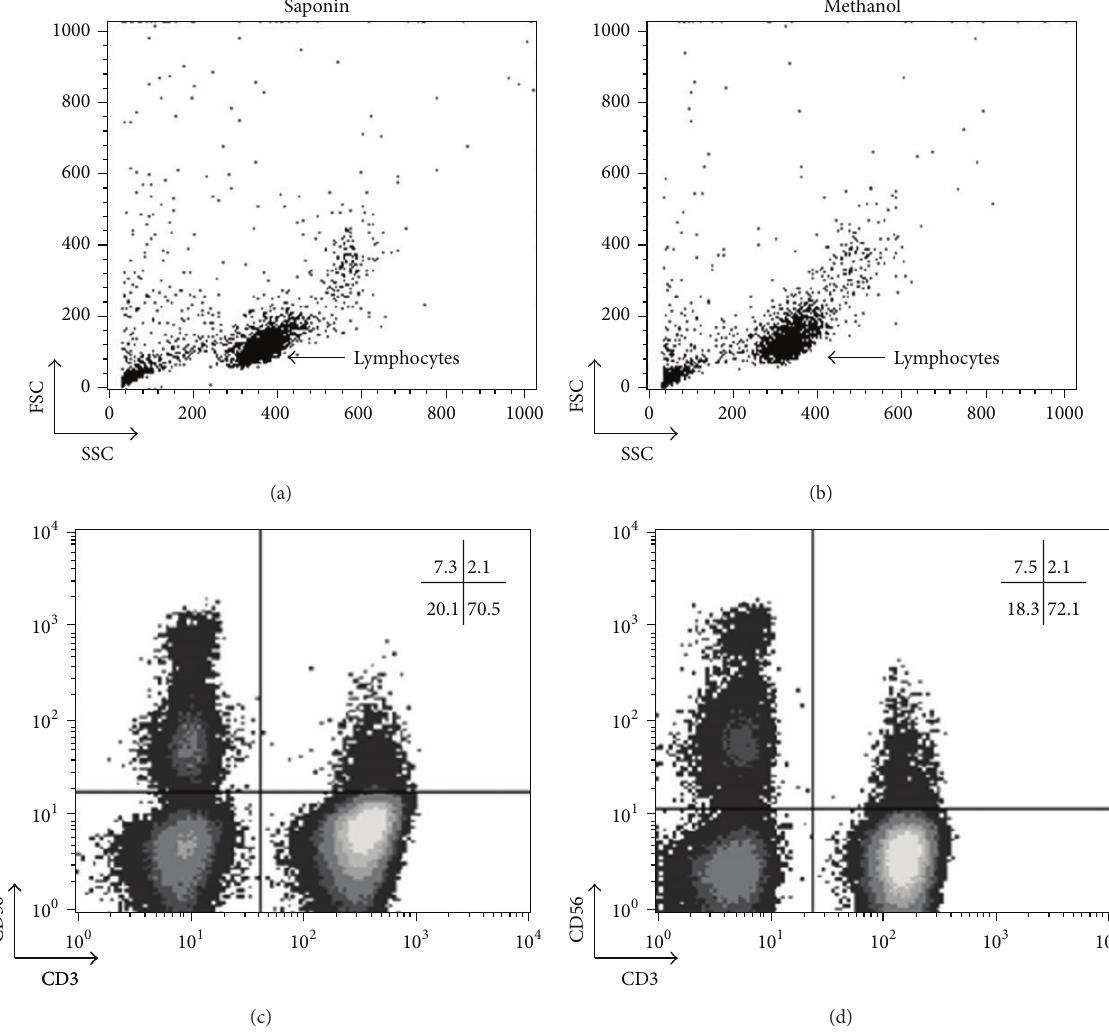
Figure 1: Comparable phenotypic analysis of peripheral blood NK, NKT, and T cells using saponin- or methanol-based permeabilization. Freshly isolated human PBMCs (1 × 10 6 ) /mL were fixed using 2% paraformaldehyde, permeabilized in saponin- (left) or methanol- (right) based buffers, and stained with anti-CD3 and anti-CD56 MoAbs. Lymphocytes were gated on forward/side light scatter properties. Discrimination of CD56+CD3 − (NK), CD56+CD3+ (NKT), and CD56 − CD3+ (T) cells was comparable between the two